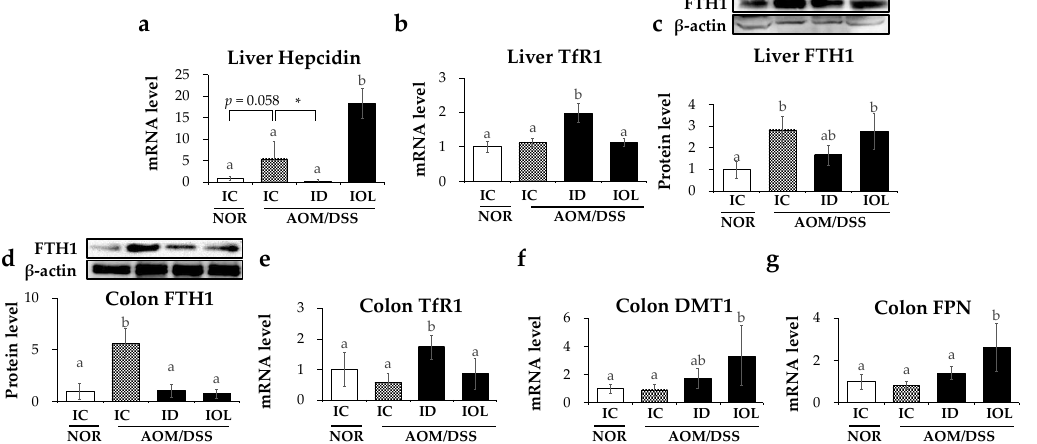
Figure 2. AOM/DSS treatment and iron overload and iron deficient diet affected the expression of iron-related genes in the AOM/DSS model. The hepatic mRNA expression levels of hepcidin ( a ) and TfR1 ( b ) were evaluated. Western blot analysis of liver FTH1 ( c ) and colonic FTH1 ( d ) was per- formed. The mRNA expression levels of TfR1 ( e ), DMT1 ( f ), and FPN ( g ) released from the large intestine tissue were measured. Mean ± SD and SE are represented. One-way ANOVA was used for the test of difference and Tukey for the post-hoc test. Different letters above the value indicate sta- tistical significance. Student’s t -test was used to test the difference between two groups, and the asterisk represents statistical significance (* p < 0.05). Abbreviations: NOR, normal; AOM/DSS, azoxymethane/dextran sodium sulfate; IC, iron control; ID, iron-deficient; IOL, iron overload; TfR1, transferrin receptor 1; FTH1, ferritin heavy chain 1; DMT1, divalent metal transporter 1; FPN, ferro- portin. 3.3. IOL and ID Diets Alleviated the Development of Colonic Tumors To investigate the effects of high or low dietary iron on the development of colon cancer, the AOM/DSS groups were compared for morphological changes in the colon tis- sues by H&E staining, the number of tumors, and the expression levels of proliferation marker genes. All H&E-stained images are shown in Figure S1. Compared with the IC + NOR group, the IC + AOM/DSS group showed severe morphological changes (Figure 3a). Tumors were also formed in the colon tissue (Figure 3b). In addition, the total tumor area for each colon was defined as the tumor burden index [48] (Figure S2). In addition, protein levels of proliferating cell nuclear antigen (PCNA), cyclin D1, and c-Myc were significantly higher in the IC + AOM/DSS group than in the IC + NOR group (Figure 3c – e). However, protein levels of PCNA and c-Myc were considerably lower in the ID + AOM/DSS and IOL + AOM/DSS groups than in the IC + AOM/DSS (Fig- ure 3c – e). Only IOL + AOM/DSS exhibited a significant reduction in cyclin D1 expression (Figure 3d). As for Bcl-2-associated X protein (Bax)/B-cell lymphoma (Bcl)-2 ratio, which